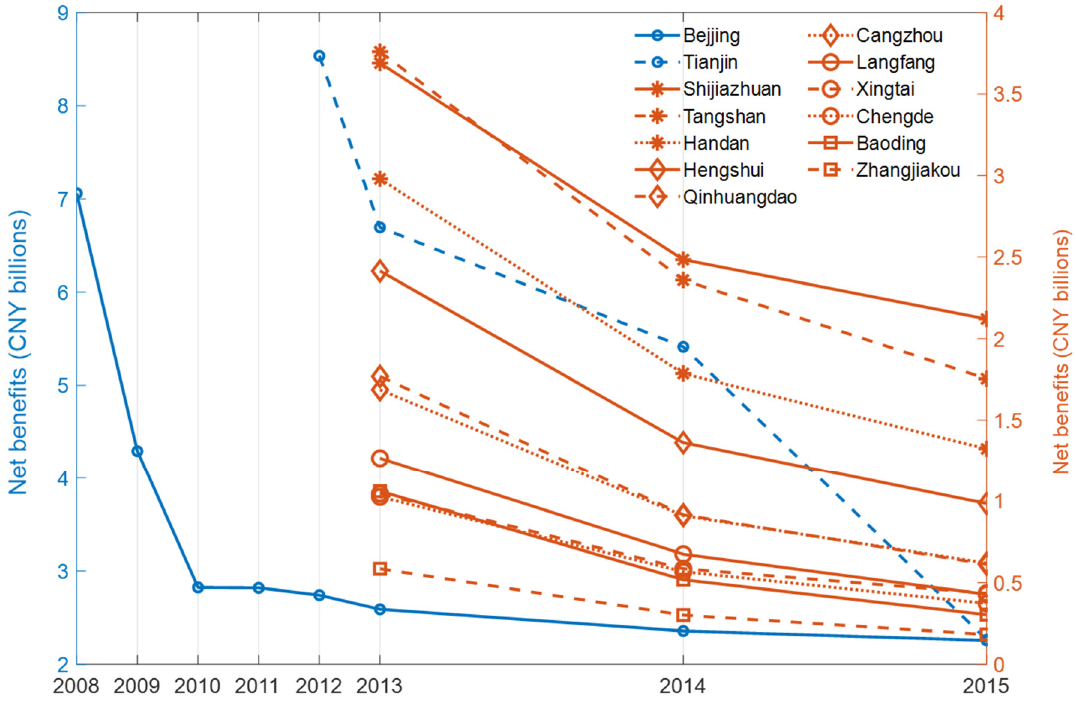
Figure 6. Net benefits of the HEV driving area restriction policy from 2008 to